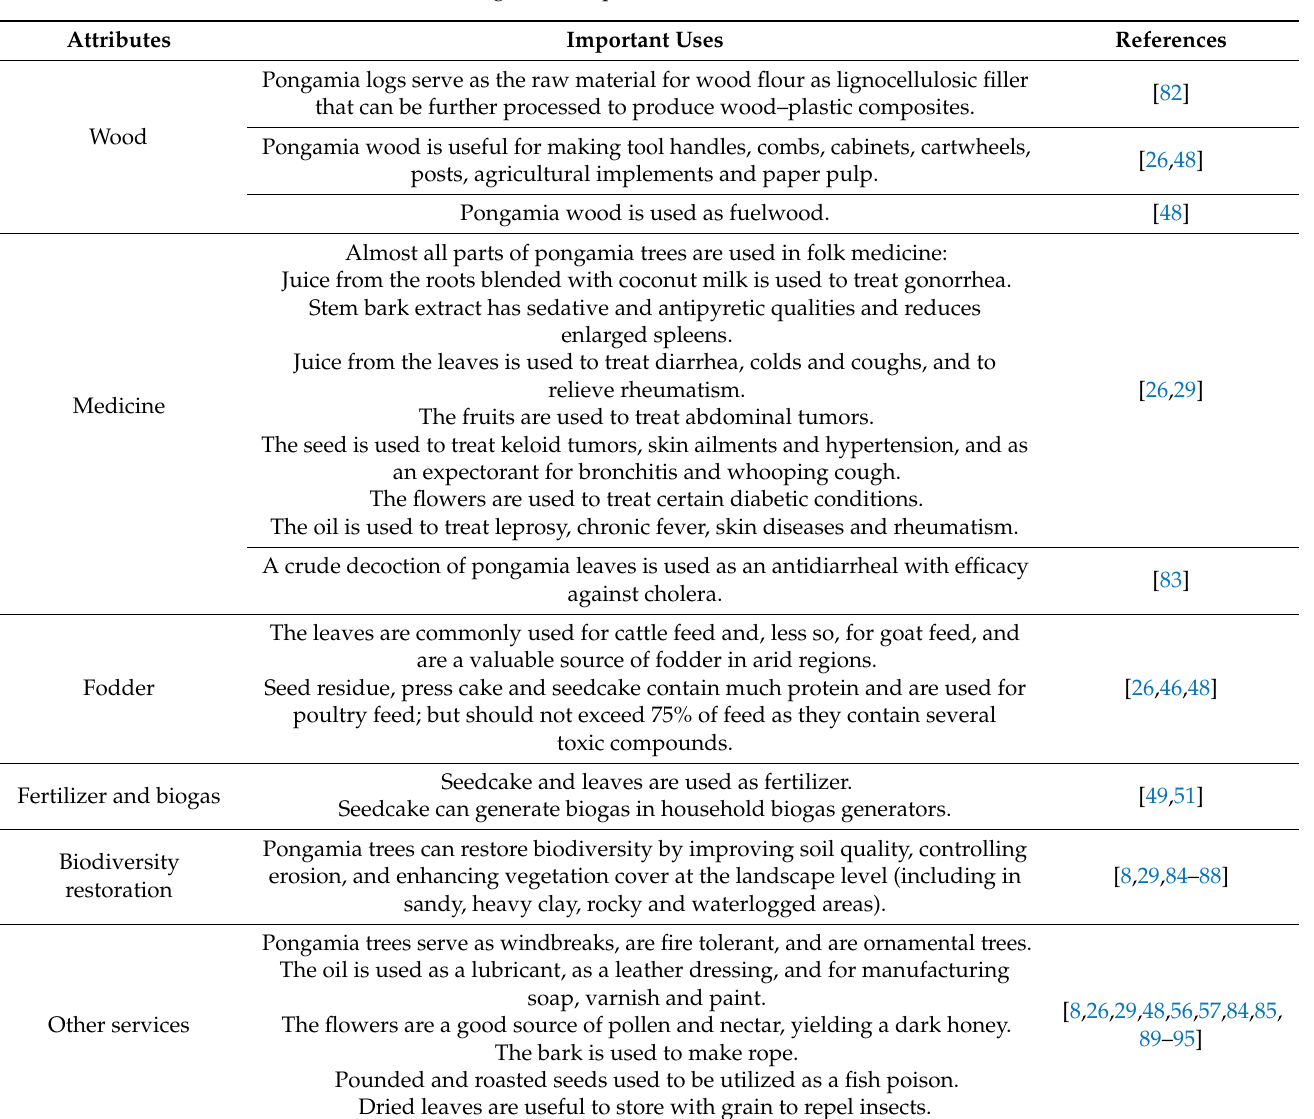
Table 6. Pongamia tree products and their various